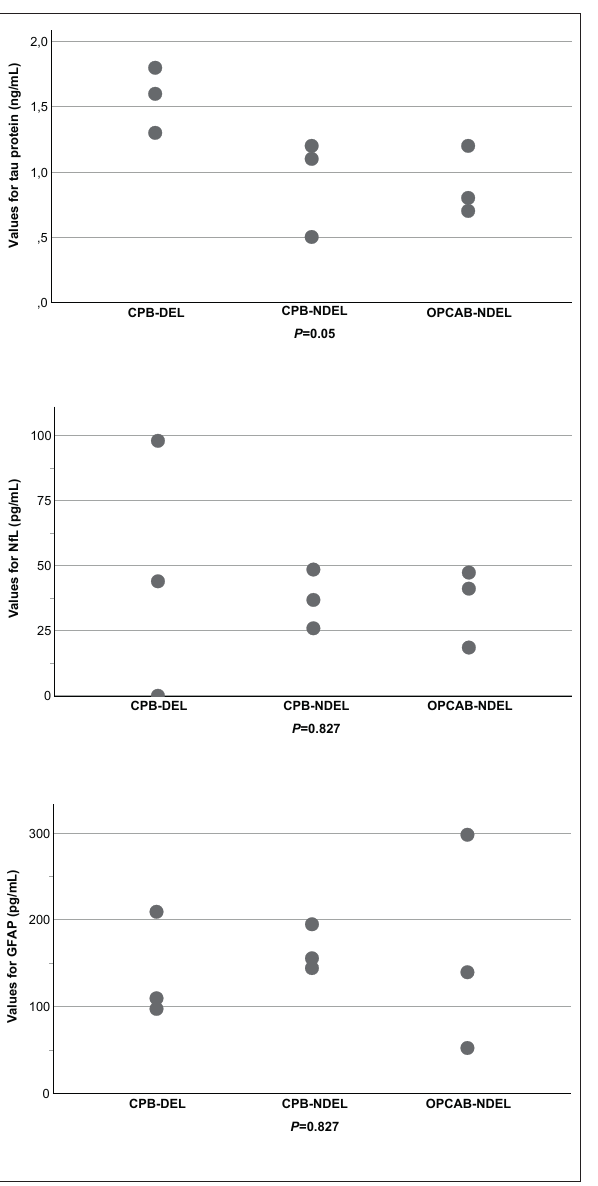
Fig. 1. Preoperative values for tau protein, NfL and GFAP. Fig. 2. Perioperative course of tau protein, NfL and